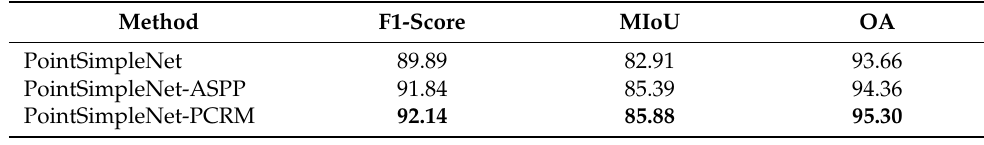
Table 8. Quantitative evaluation of refinement module PCRM through three groups of comparative experiments (%) on the OCS point cloud dataset. The best metrics are highlighted in bold.